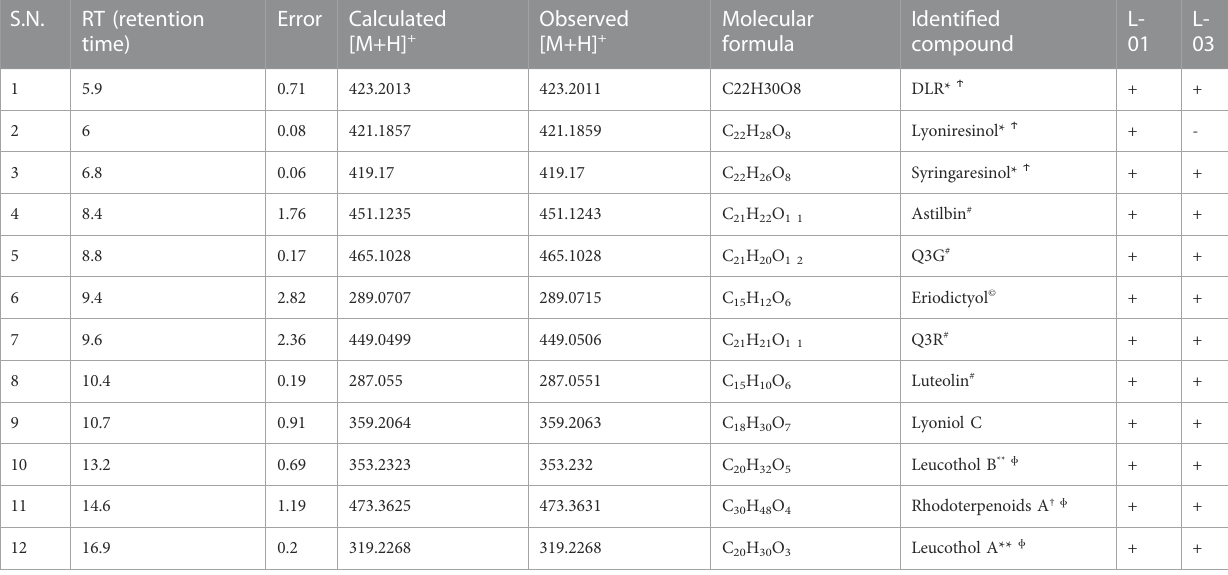
TABLE 2 HPLC-ESI-QTOF-MS determination of ethanolic extract (L-01) and ethyl acetate fraction (L-03) of L. ovalifolia . S.N.